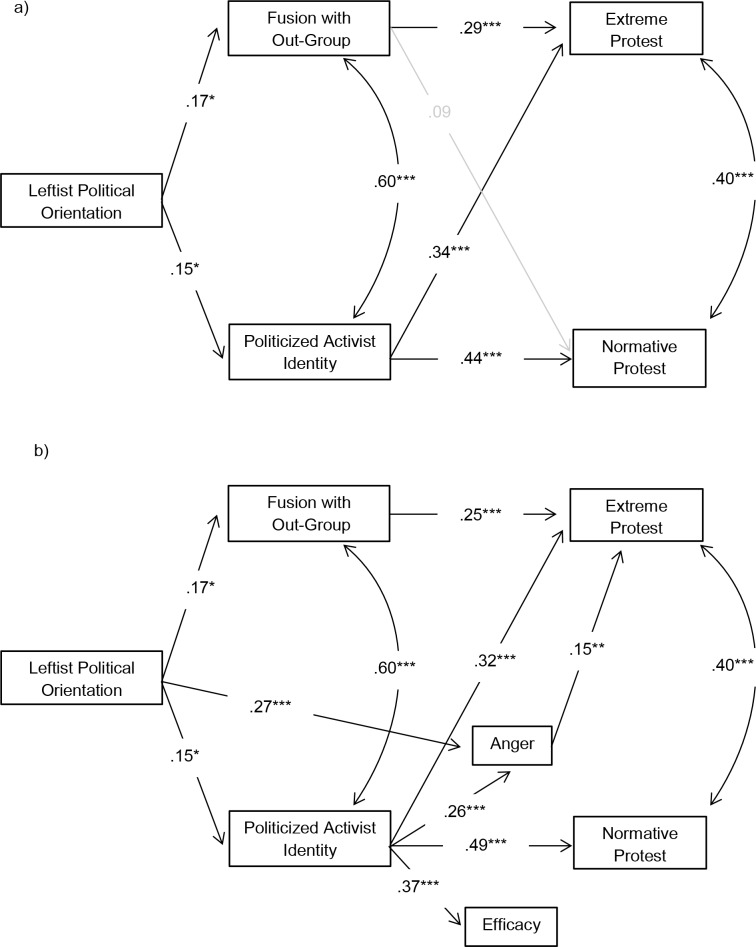
Simple (a), and more complex and fitted (b), mediation models for Study 1 are displayed. Non-significant paths are displayed in grey. The correlation between anger and efficacy in Model b) is not displayed for purposes of presentation: ranger, efficacy = .30, p < .001.